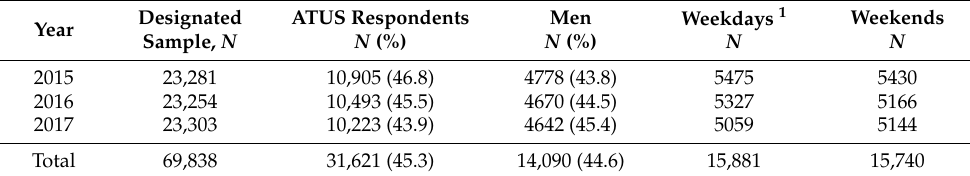
Table 2. Configuration of the American Time Use Survey (ATUS) database from 2015 to